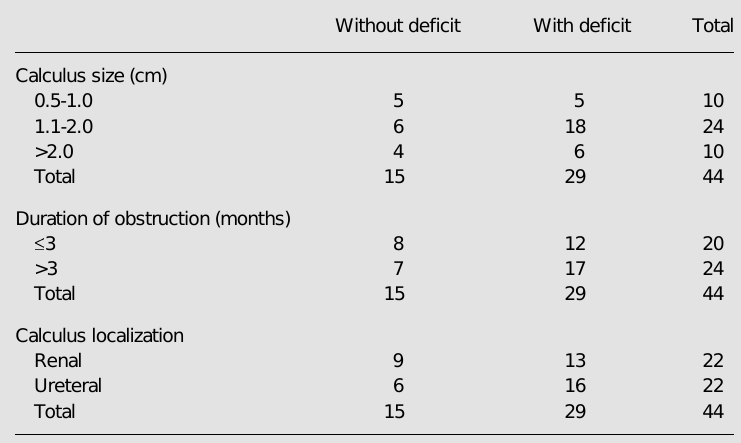
Table 2. Association between unilateral functional deficit and calculus size, duration of obstruction and calculus localization on 99m Tc-dimercaptosuccinic acid (DMSA) scintig-